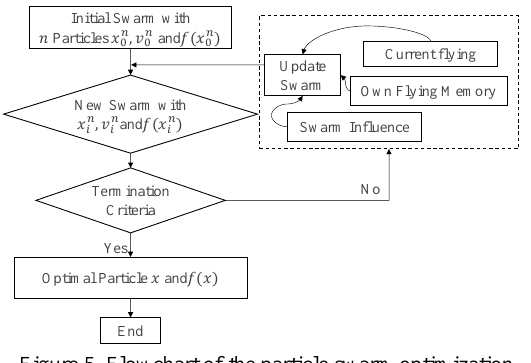
Figure 5. Flowchart of the particle swarm optimization